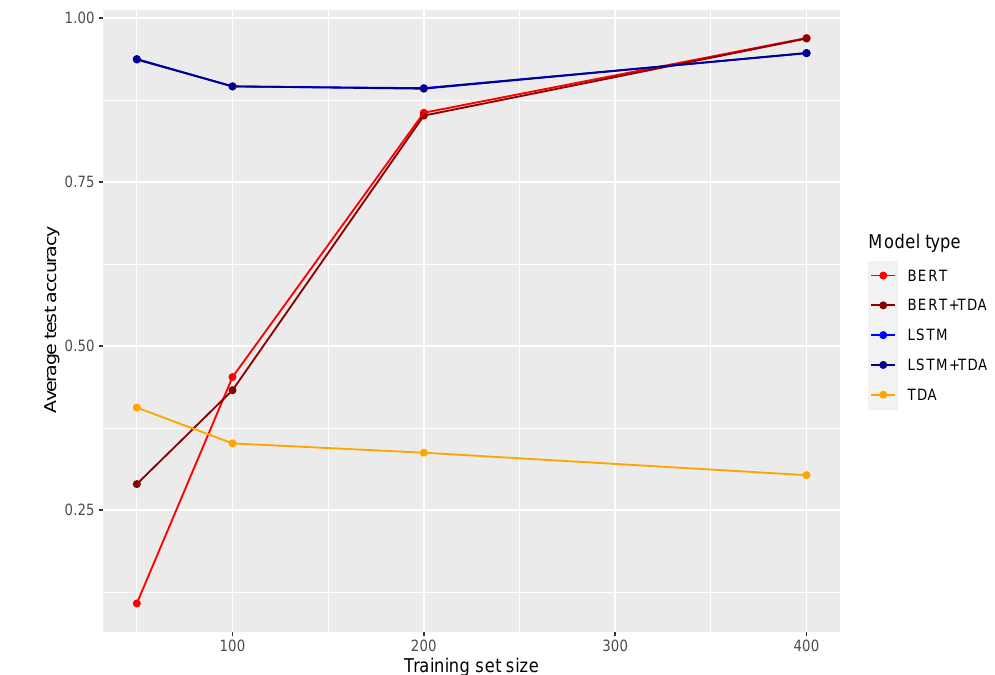
Figure 10. Average accuracy of our models in detecting fake news articles generated by GPT-3 (i.e., not the type of articles the models were trained on). Note that the LSTM accuracy line coincides with the LSTM + TDA accuracy